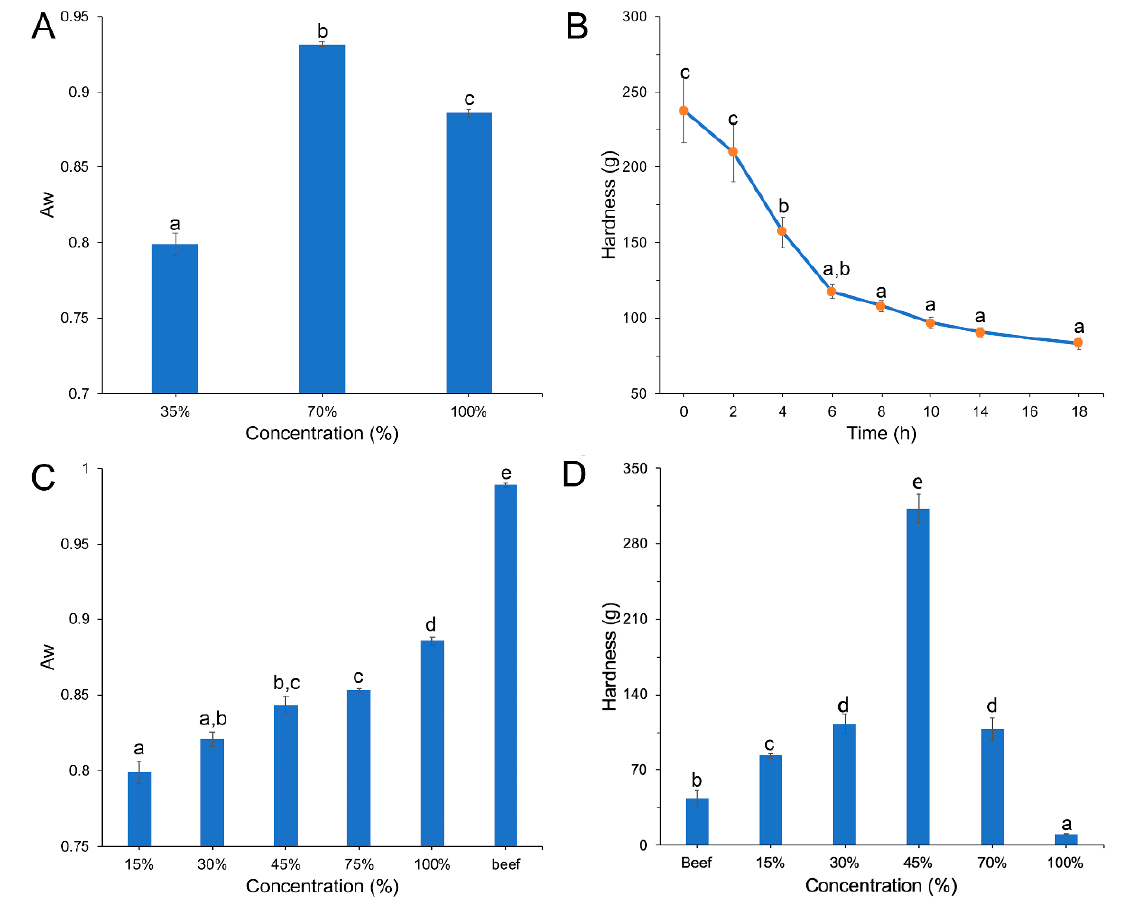
Figure 2. ( A ) The a w of mushroom-based meat analogues with water contents from 35% to 100%; ( B ) The hardness of mushroom-based meat analogues with different rehydration times; ( C ) The a w and ( D ) hardness of mushroom-based meat analogues with contents of edible mushroom from 15% to 100% compared with beef.